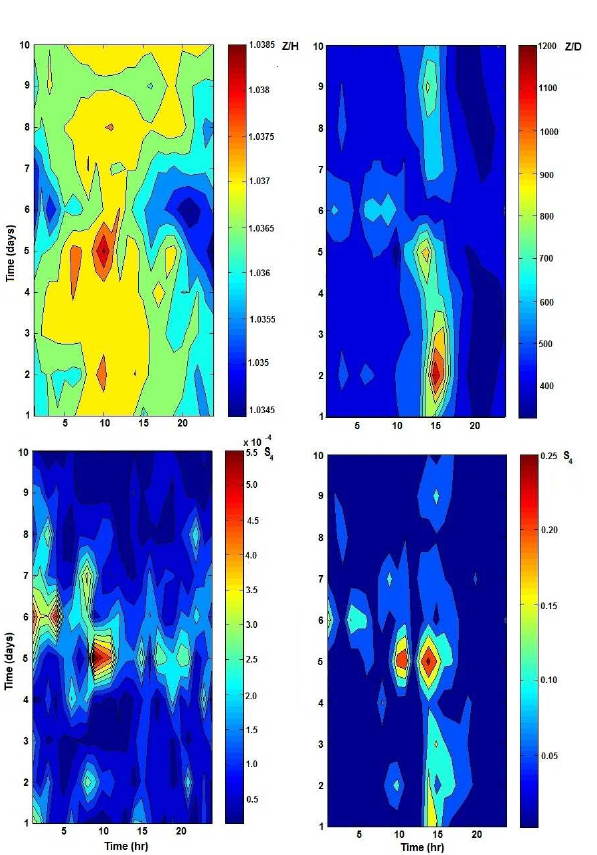
Figure 3. Map showing the time series of: the analysis for the first event Z/H (top right), and 3 Fig. 3. Map showing the time series of the analysis for the first event Z/H (top right), and Z/D (top left). At the bottom, the variation Z/D (top left). At the bottom, the variation index for Z/H (left), and for Z/D (right). 4 index for Z/H (left), and for Z/D (right).